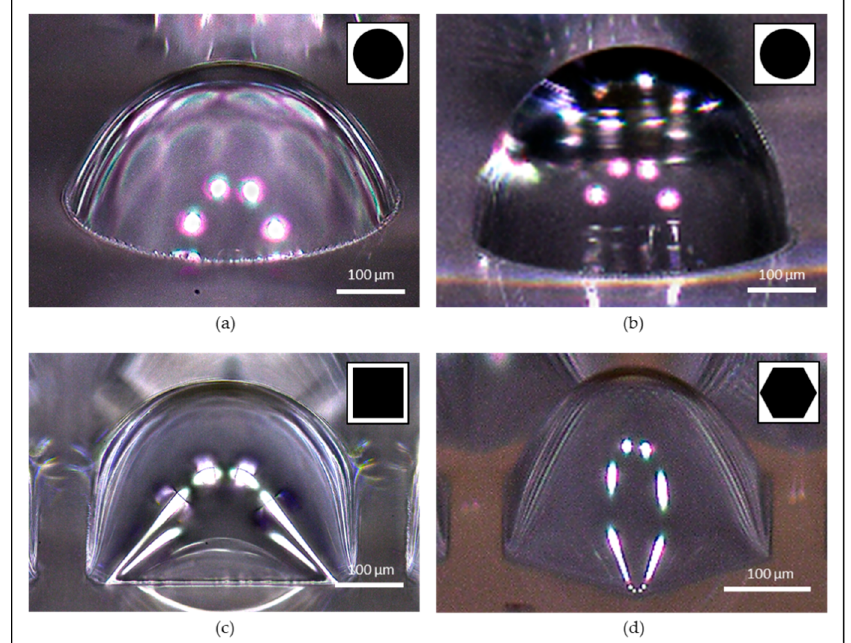
Figure 6. Microlens arrays (MLAs) fabricated using the TDTR process with varying development time or aperture geometry. Circular aperture microlens with a diameter of 500 µm with: ( a ) 10 min development; ( b ) 20 min development; ( c ) square aperture and the side length of 500 µm with 10 min development; ( d ) hexagonal aperture with an inner circle diameter of 300 µm with 20 min development.